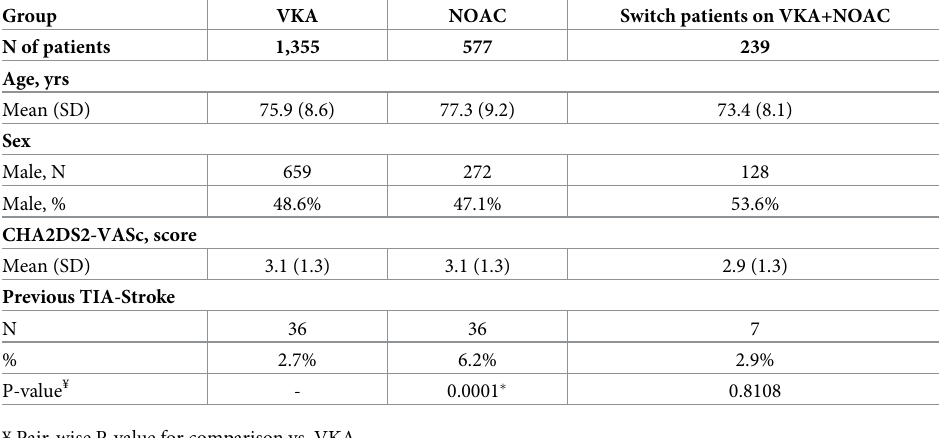
Table 1. AF treatment patient characteristics (VKA: VKA Group—NOAC: NOAC Group). Group